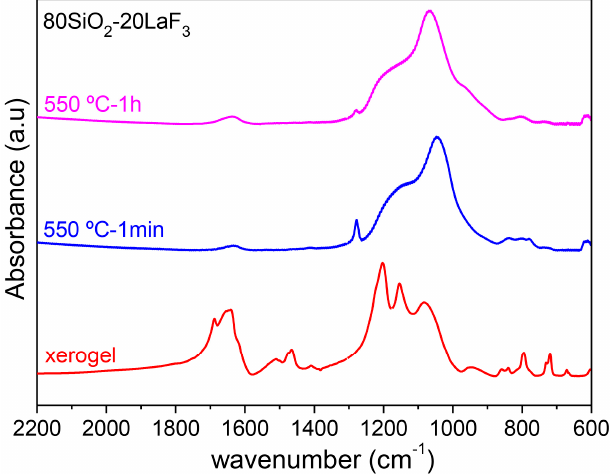
Figure 12. FTIR of 80SiO 2 -20LaF 3 xerogel and GC self-supported layer treated at 550 °C for 1 min and 1 h.